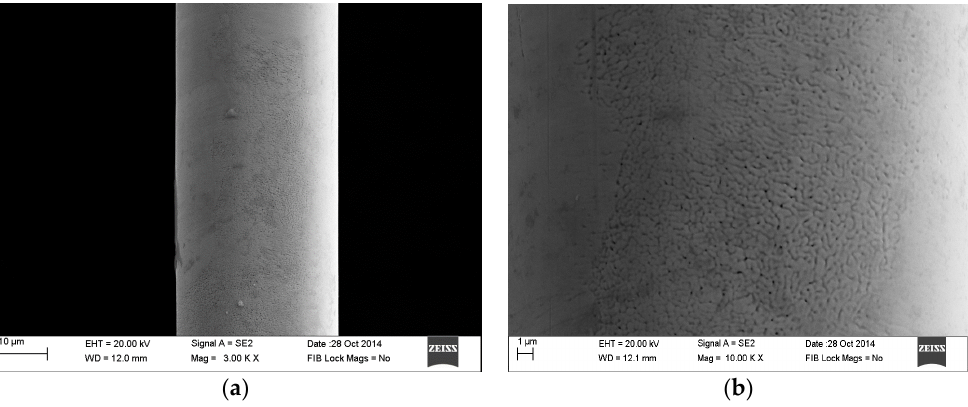
Figure 4. Morphology of the fibers. ( a ) SEM micrograph of the Ni54.9–Mn23.5–Ga21.6 fiber with a diameter of 33 μ m; ( b ) magnified image of the surface.